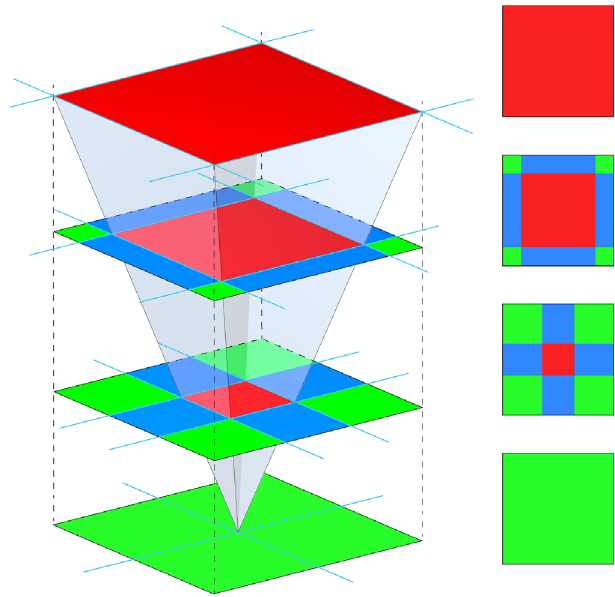
Figure 43. Projective equivalence with cutting with d i knife for squares d m =